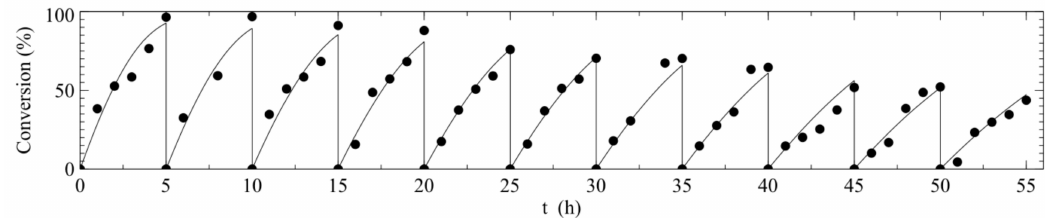
Figure 3. Gluconic acid production from glucose (26 g L − 1 ) in a bubble column reactor kept at 40 ◦ C and pH 6.0. The curves represent the Michaelis-Menten integrated model combined to the first order equation of enzyme inactivation (Equation (5)) fitted to the experimental data of reuse of GOD / CAT combi-CLEA ( K m,app = 65.8 ± 18.5 mM and k cat,app = 9.82 ·± 1.25 × 10 3 h − 1 , k d = 0.0204 ± 0.0008 h − 1 ). Table 3. Kinetic parameters of an integrated Michaelis-Menten model fitted to the experimental data of oxidation of glucose to gluconic acid catalyzed by soluble and immobilized GOD / CAT. GOD / CAT K m,app (mM) k cat,app (h − 1 ) 1 k cat,app / K m,app R 2 Soluble 51.1 ± 13.4 (1.16 ·± 0.12) × 10 4 227.0 0.95 Combi-CLEAs 65.8 ±